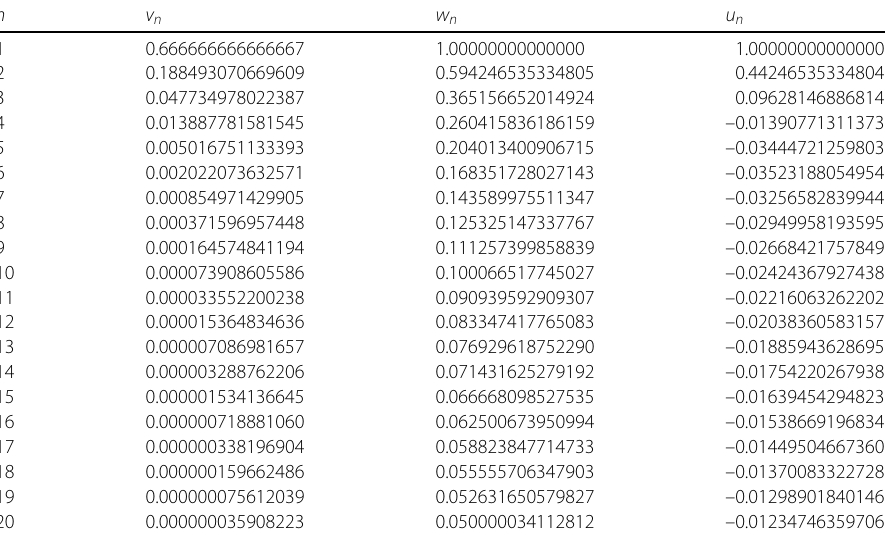
Table 2 Numerical esults of { u n } , { v n } , and { w n } with initial u 1 = 1.0 n v n w n u